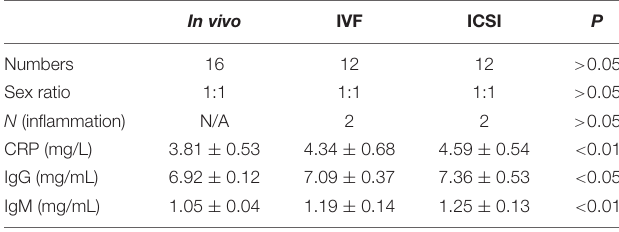
TABLE 2 | Plasma analysis of the aged mice conceived by ART and in